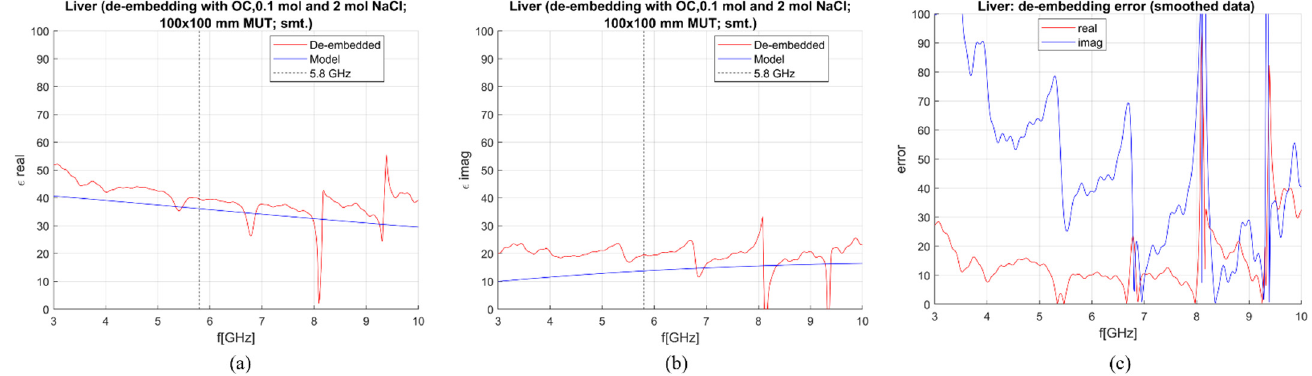
Figure 7. S&S de-embedding with the 1st calibration option: OC, 0.1 mol and 2 mol NaCl (smoothing applied): ( a ) Calculated vs. reference ε ’; ( b ) calculated vs. reference ε ’’; ( c ) sensitivity (de-embedding error) for ε ’ (“real”) and ε ’’ (“imag”).